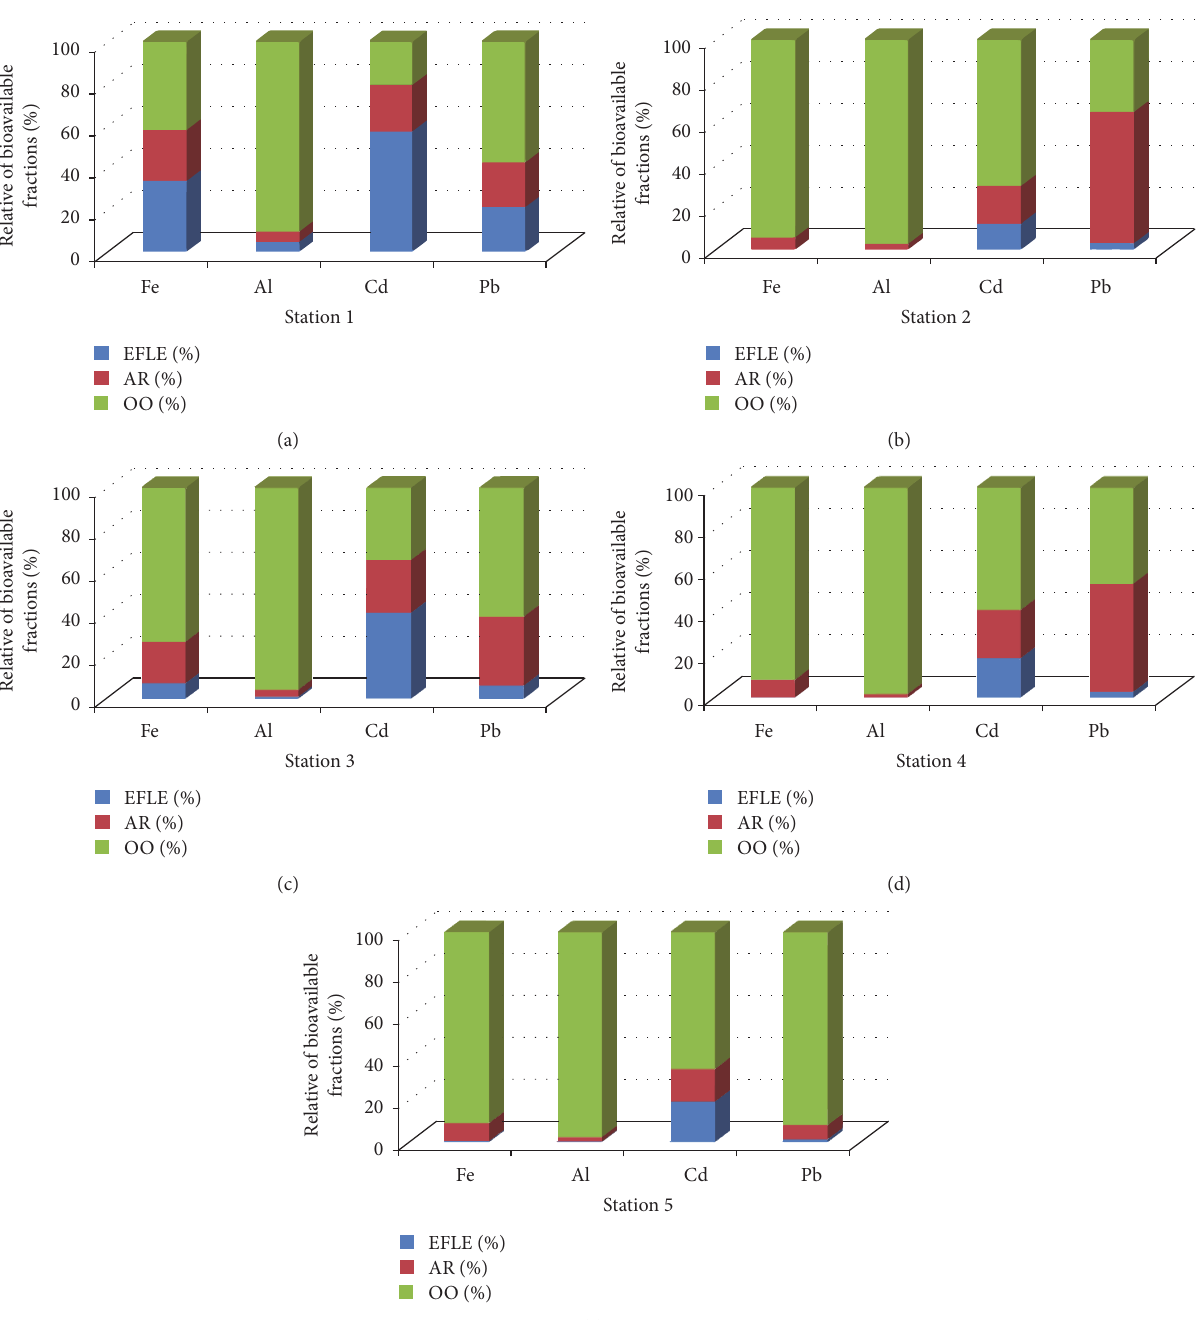
respectively. According to Watanabe and Osaki [44],